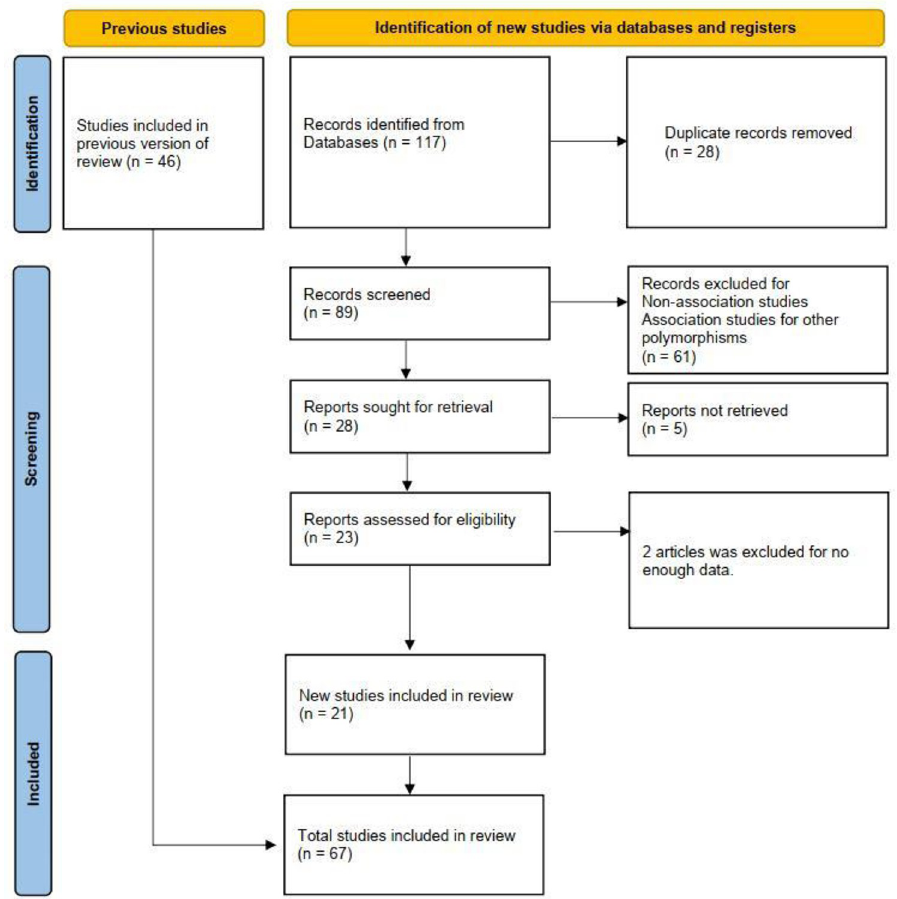
Fig 1. Flow of study identification, inclusion and